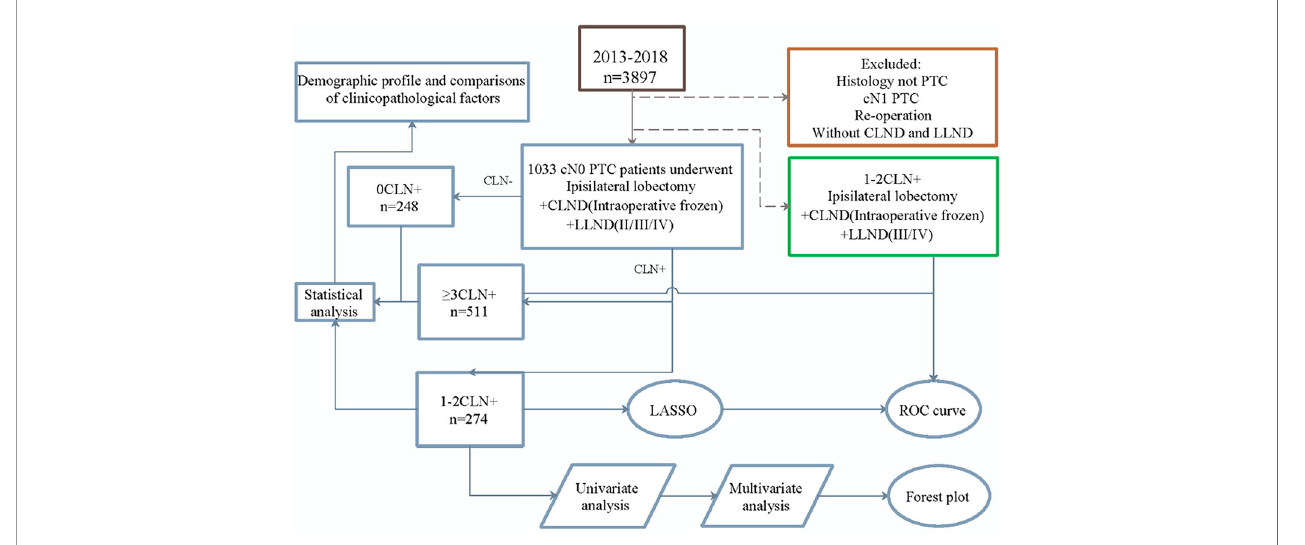
FIGURE 1 | Overall fl owchart of the study design.